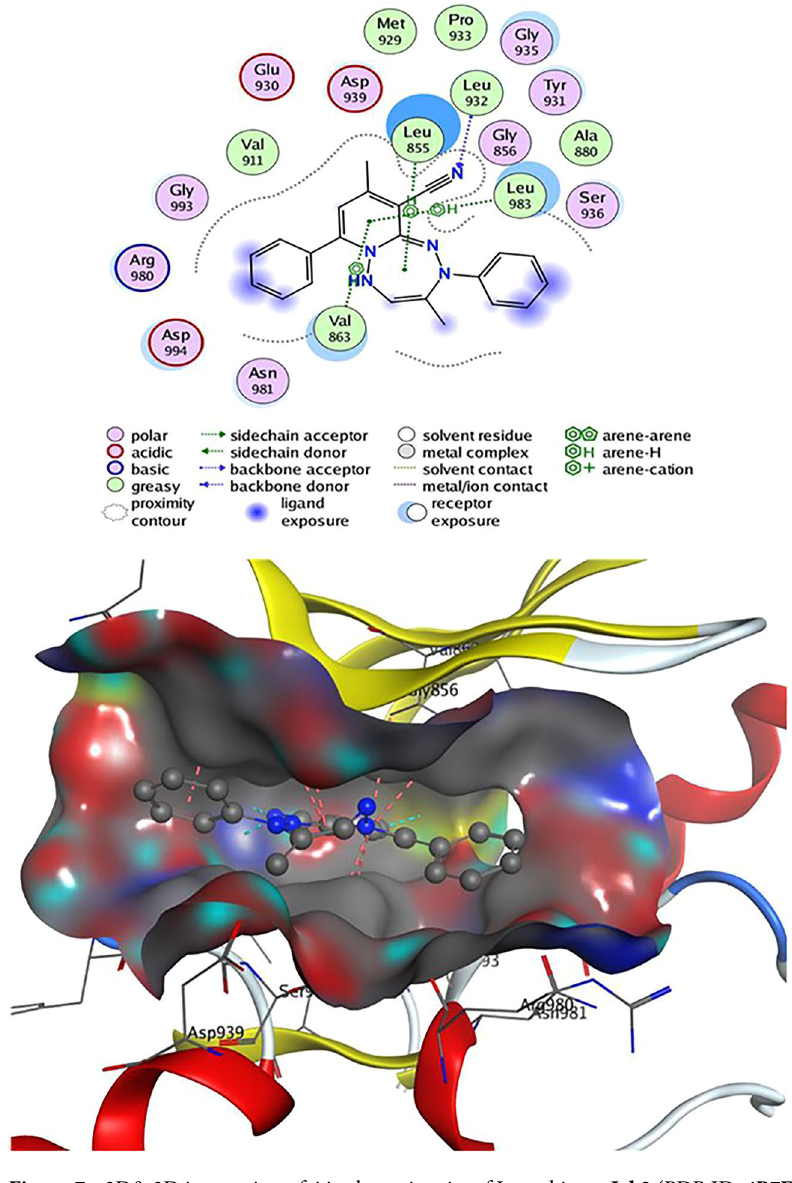
Figure 7. 2D& 3D interaction of 4 in the active site of Janus kinase Jak2 (PDB ID: 4P7E ). Hydrogen bonds are displayed in cyan & H-pi-bonds are in dark